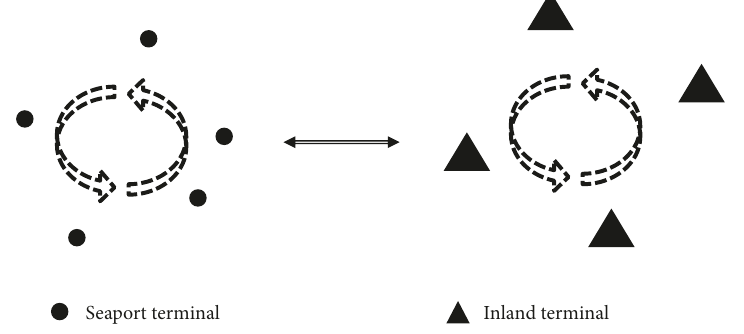
Figure 1: Schematic representation of an ITT